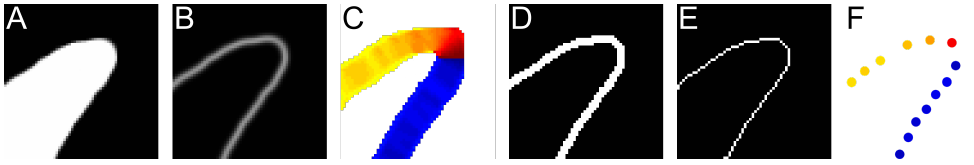
Figure 1. ( A ) Segmented leaf; ( B ) Edge magnitude response; ( C ) Edge phase response; ( D ) Thresholded edge magnitude response; ( E ) Thinned thresholded edge magnitude response; ( F ) Subdivision of edge phase